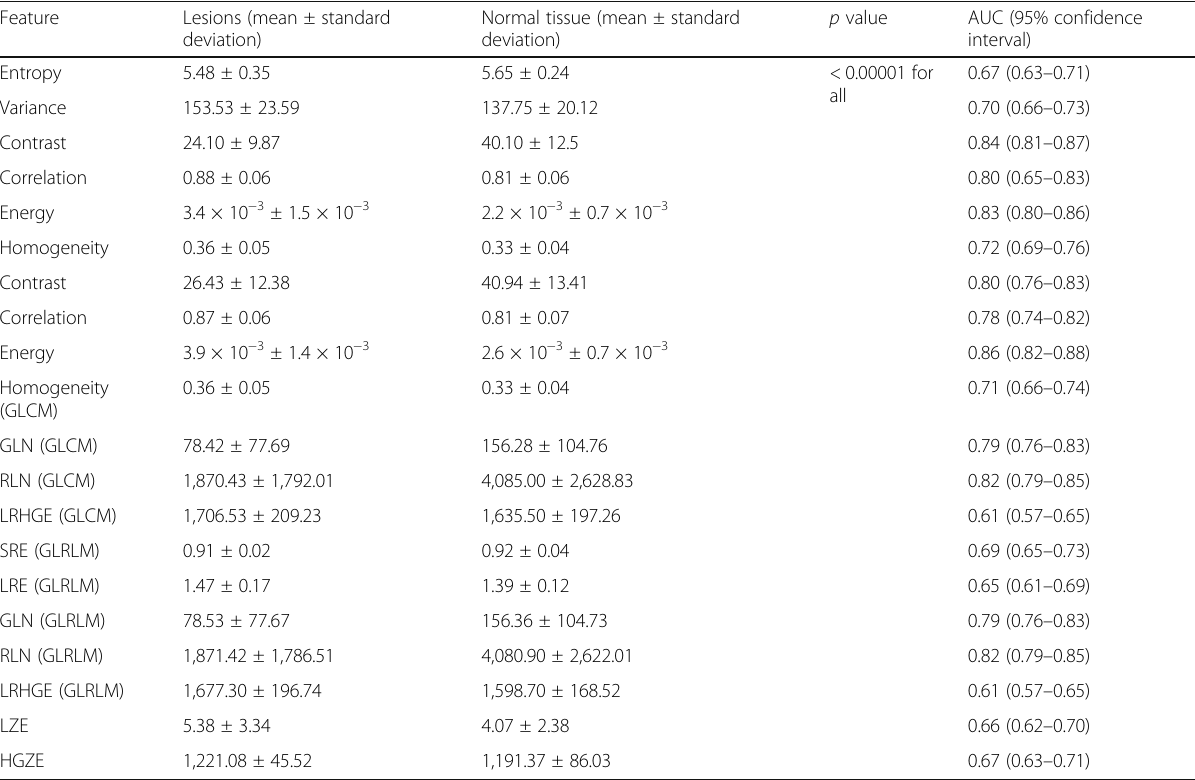
Table 2 Texture features that showed significantly different mean values comparing lesions (benign and malignant) versus normal tissue (fat and fibroglandular) and corresponding area under the curve (AUC) Feature Lesions (mean ± standard